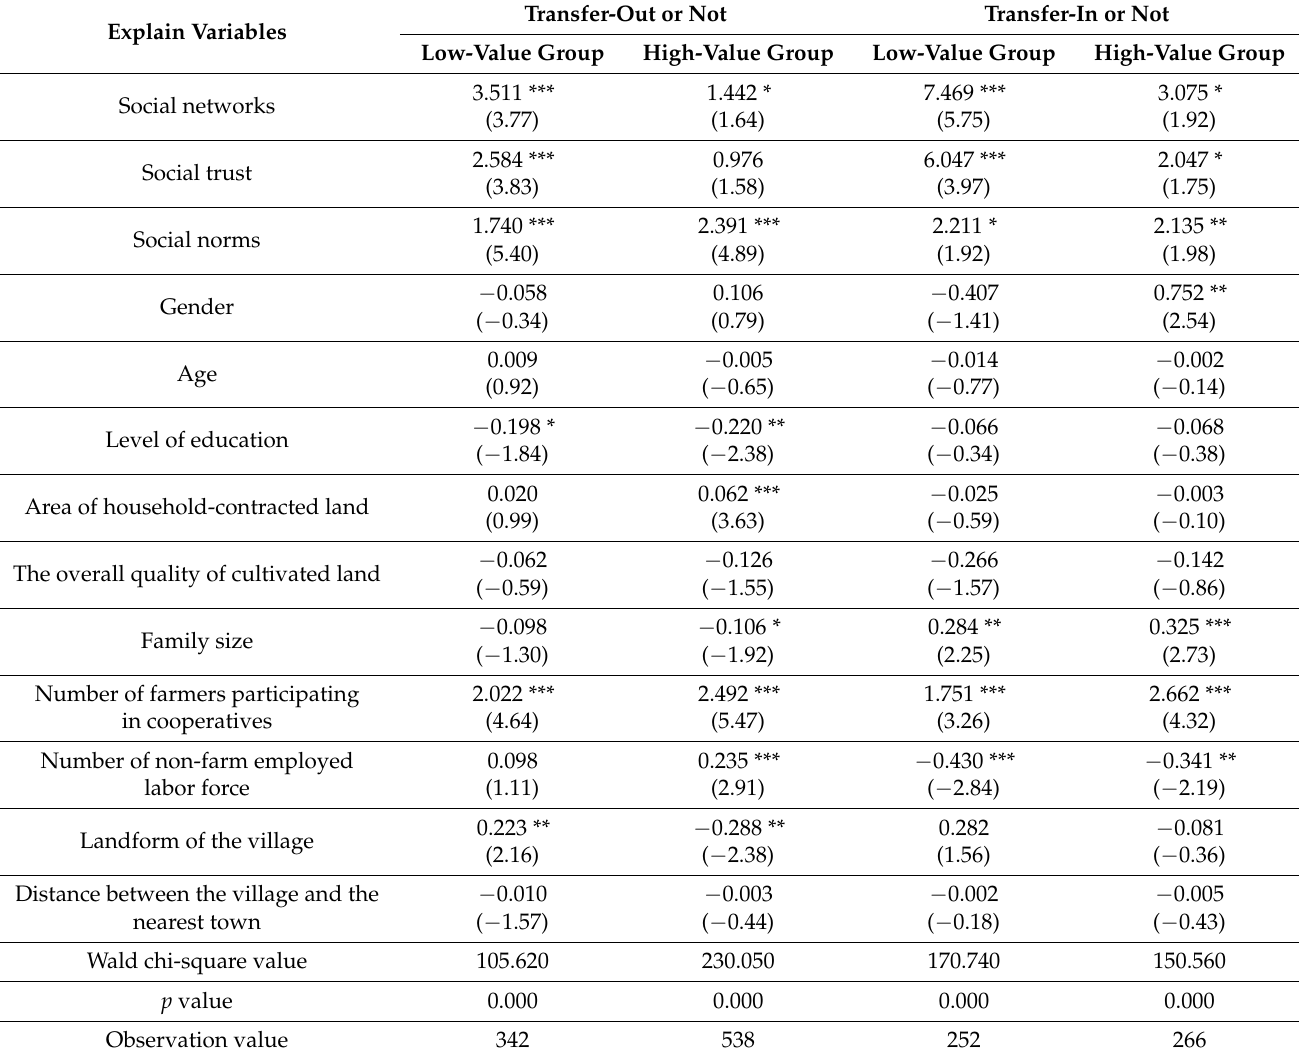
Table 6. Analysis of the effect of marketization on social capital influencing agricultural land transfer.